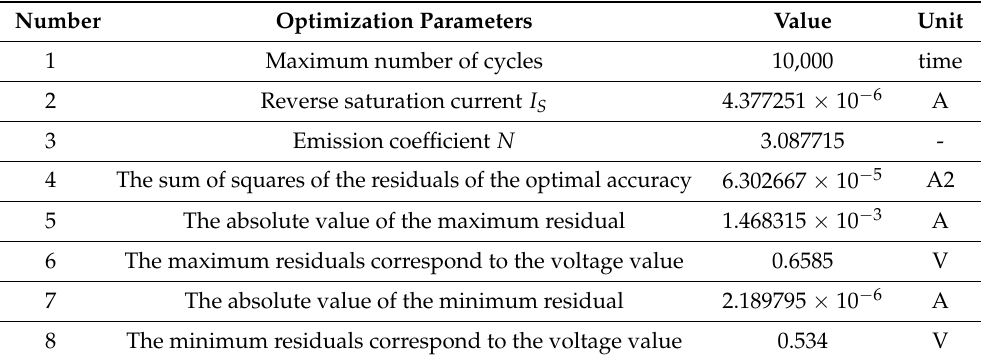
Table 2. Parameter fitting result of the forward I-V characteristic model of the diode.